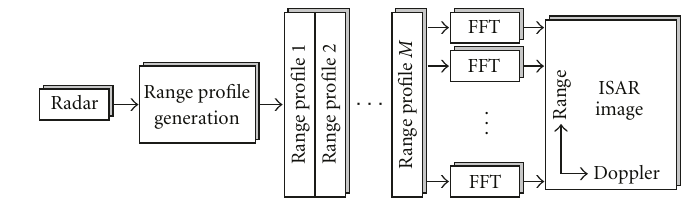
Figure 1: Range-Doppler algorithm flowchart.